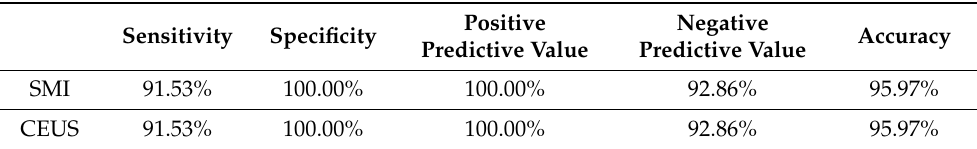
Table 3. Statistical results of sensitivity, specificity, positive and negative predictive values, and accuracy of SMI and CEUS examinations as compared with CTA. Positive Negative Accuracy Sensitivity Specificity Predictive Value Predictive Value SMI 91.53% 100.00% 100.00% 92.86% 95.97% CEUS 91.53% 100.00% 100.00% 92.86%